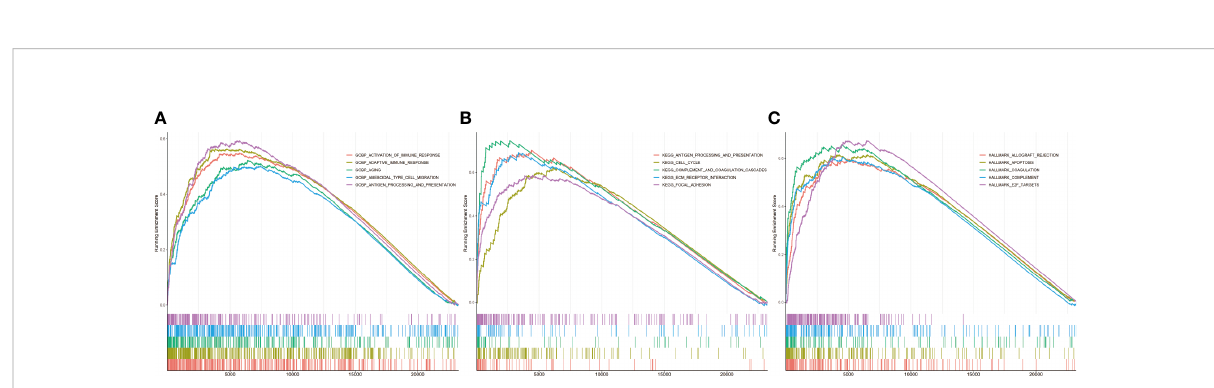
FIGURE 5 Related pathways analyzed by GSEA in the CGGA database. (A) GO analysis of CASP6 . (B) KEGG analysis of CASP6 . (C) Hallmark analysis of CASP6